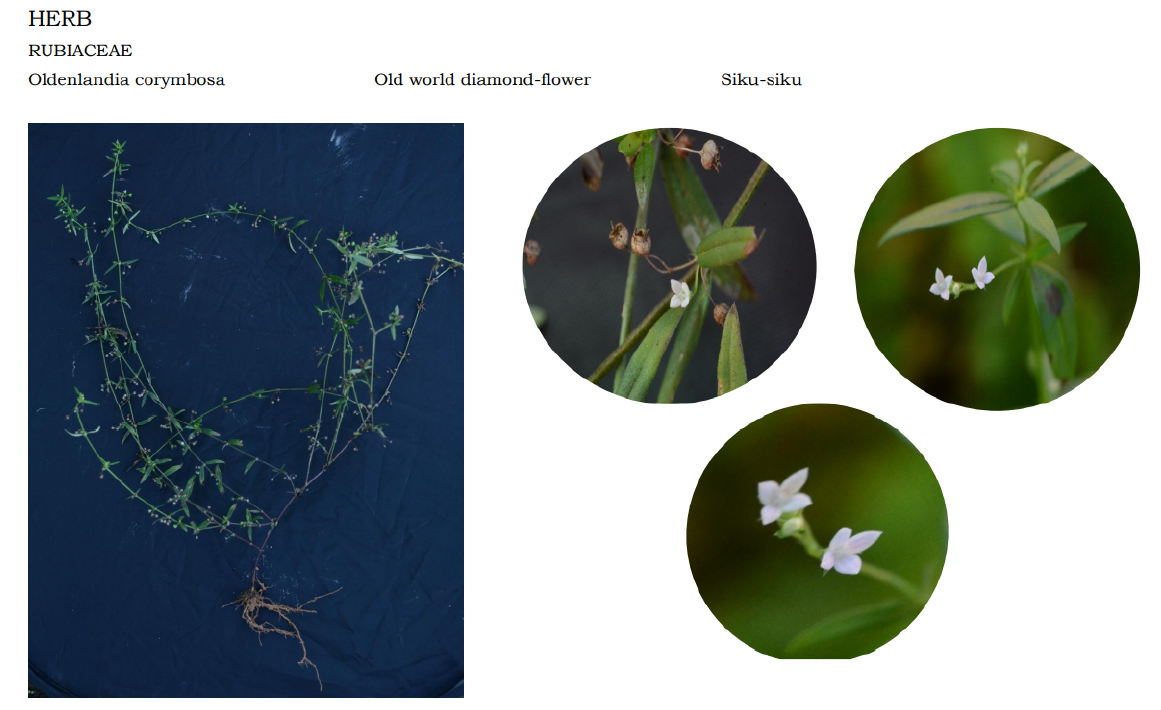
Figure A7. Sedge Cyperaceae: Fimbristylis globulosa.